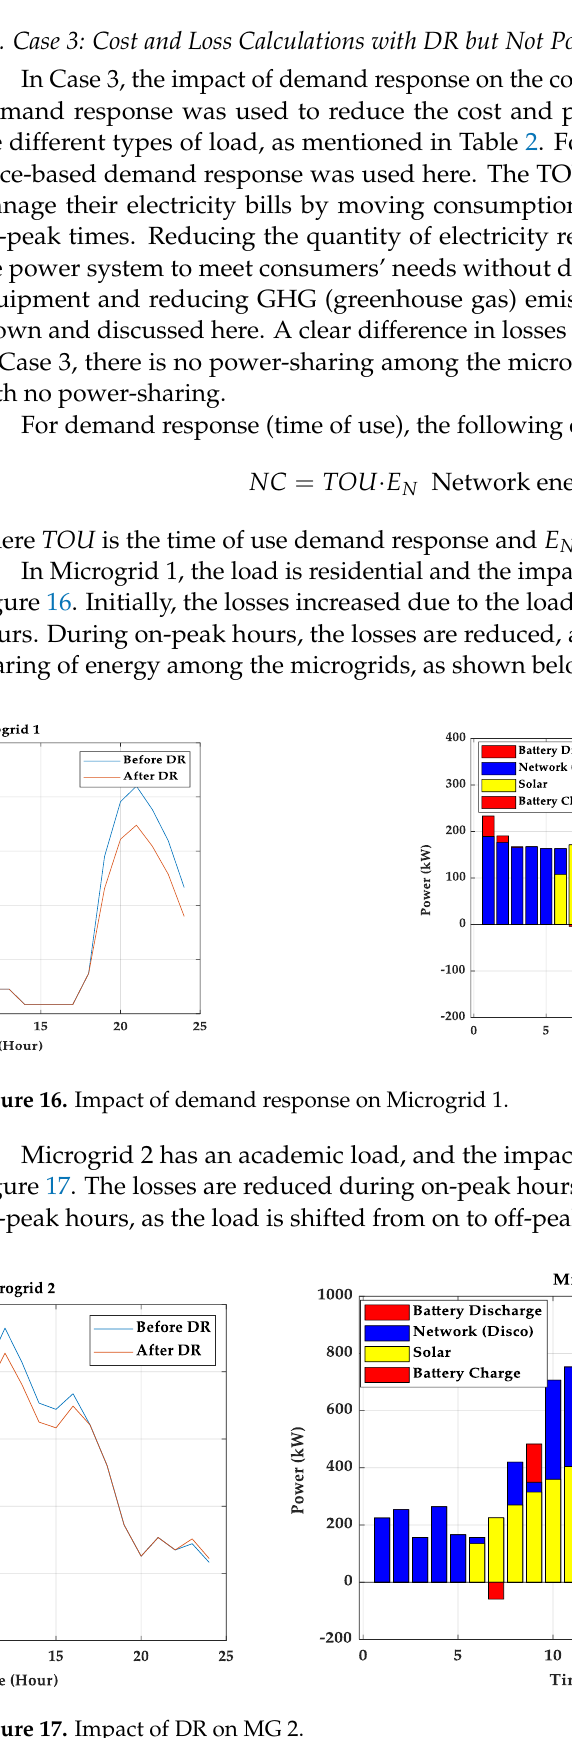
Figure 15. Case 2: total cost and energy-sharing.